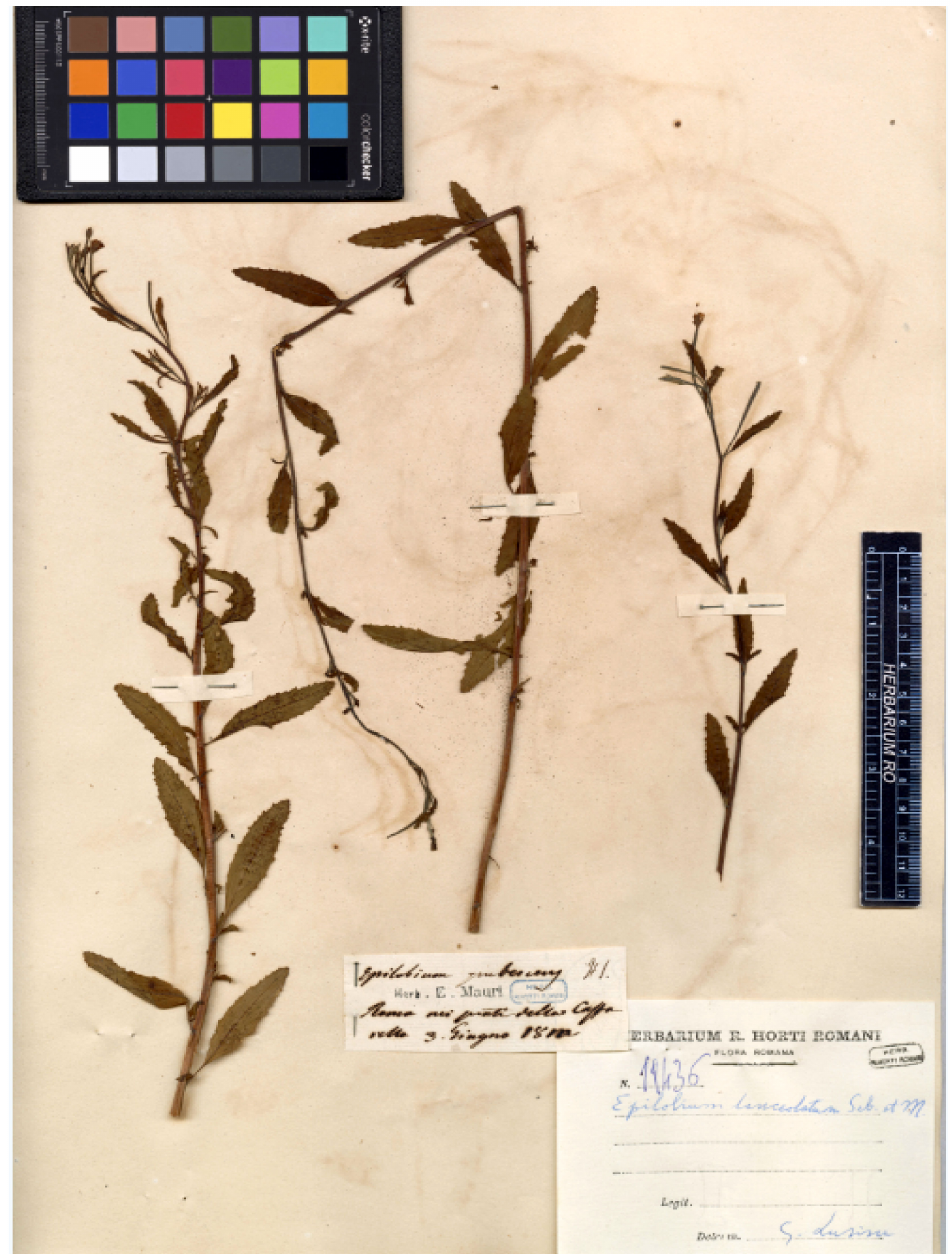
Figure 72. Lectotype of Epilobium lanceolatum (RO no.